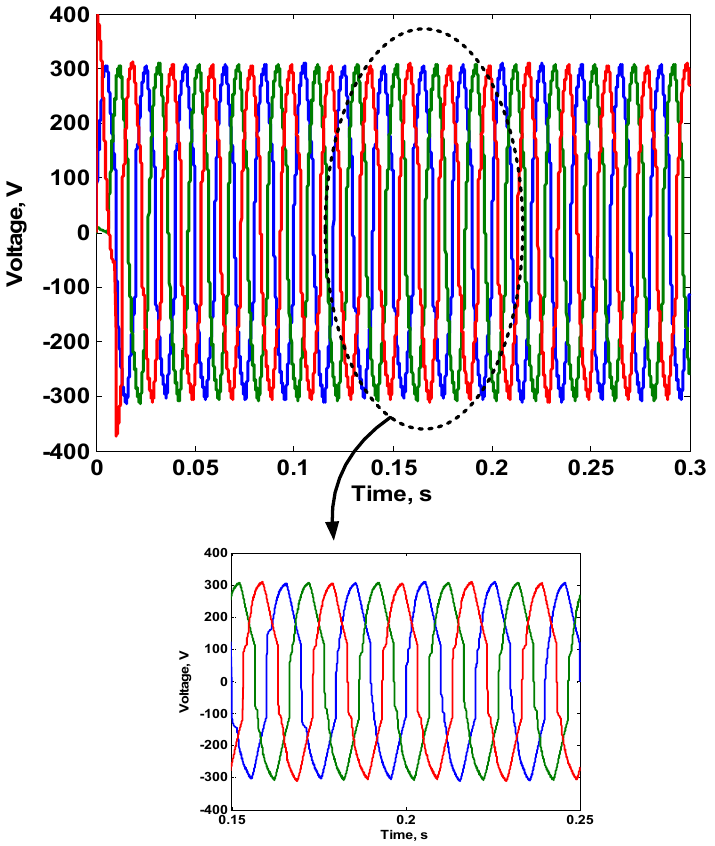
Figure 27. Three-Phase Voltages at Motor Terminals during Two-Battery Failure.